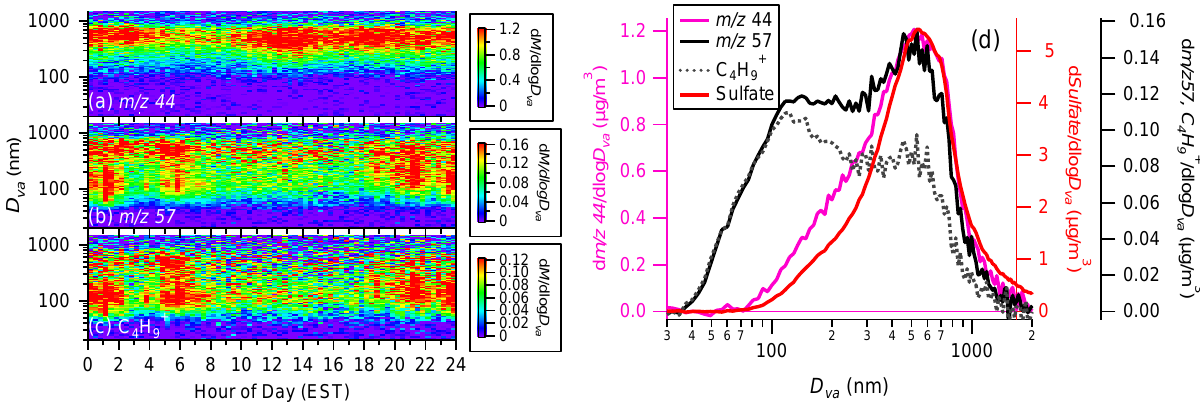
Fig. 7. Diurnal evolution of the size distributions of (a) m/z 44, (b) m/z 57, and (c) C 4 H + 44, C 4 H + , and sulfate for entire 9